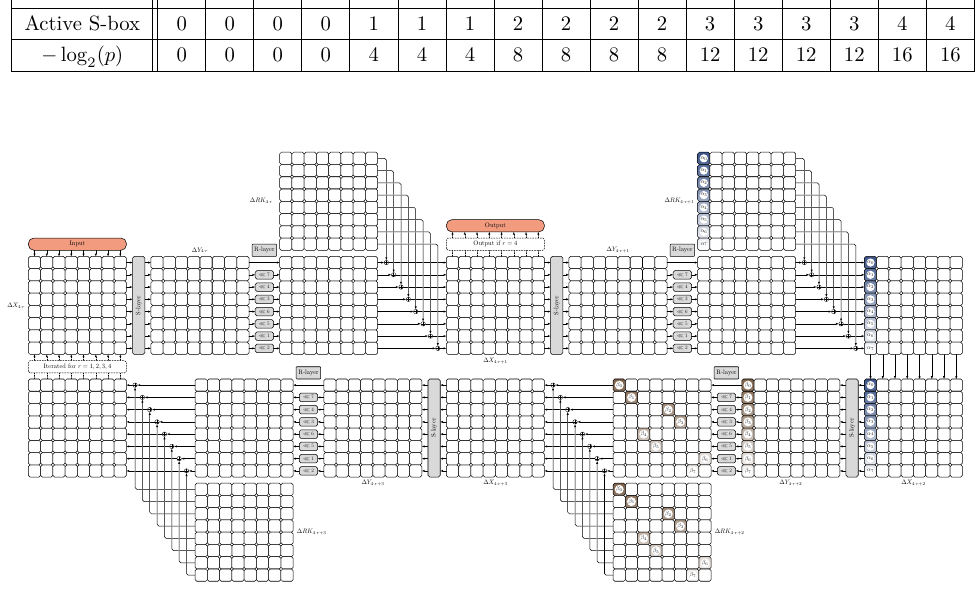
Figure 10: Full-round related-key differential characteristic with probability 2 − 16 for ble differential propagation for the S-box with probability 2 − 4